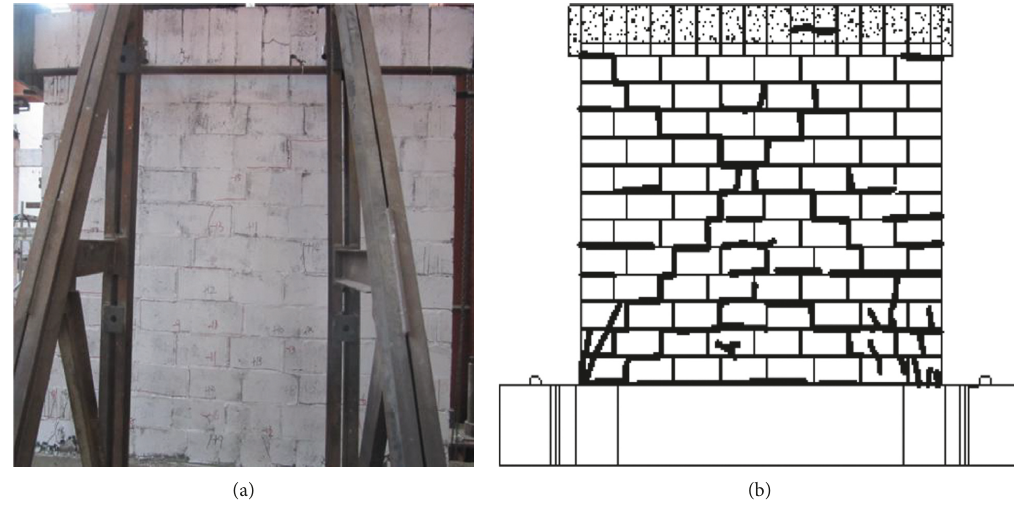
Figure 8: (a) Failure mode and (b) crack distribution of wall